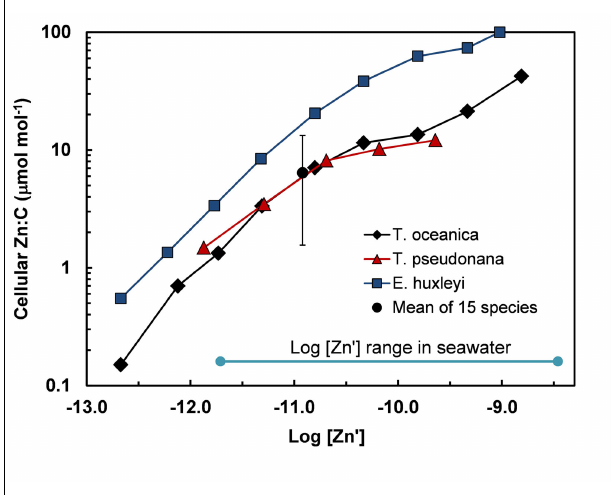
FIGURE 5 | Cellular Zn:C vs log [Zn (cid:2) ] in the oceanic diatom Thalassiosira oceanica , the coastal diatom T. pseudonana , and the oceanic coccoclithophore Emiliania huxleyi in seawater at 20˚C based on data from Sunda and Huntsman (1995a). These results are compared with the mean and range (errors bars) of Zn:C measured at the same temperature and a single [Zn (cid:2) ] in 15 different species of marine eukarotic phytoplankton from five major algal groups (Ho et al., 2003).The log [Zn (cid:2) ] range for ocean water is shown based on data of Bruland (1989) ( Table 1